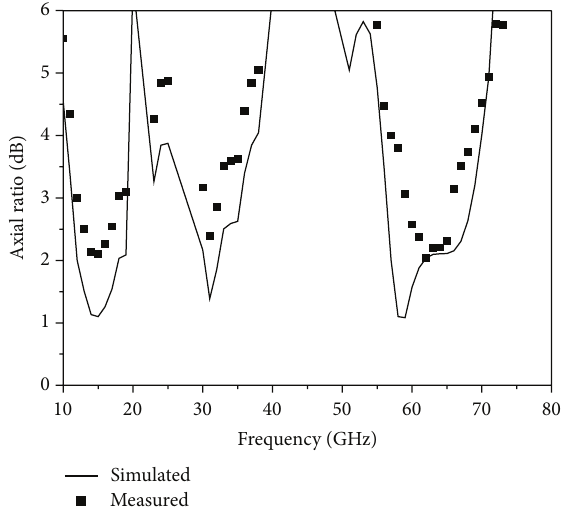
Figure 4: Simulated and measured axial ratio of the proposed antenna.